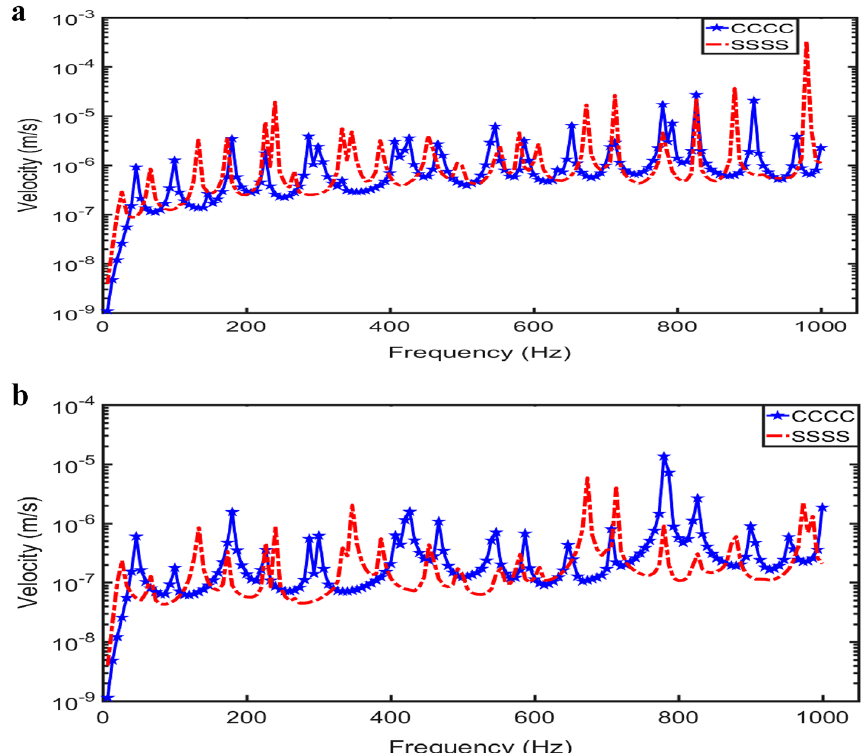
Figure 7. Velocity-frequency response comparison of two finite element models with the same modelling parameters but different boundary conditions for sound source generated at ( a ) NBC, ( b ) FBC.